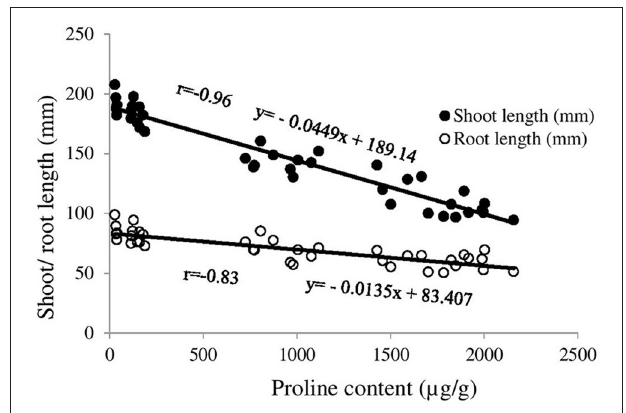
FIGURE 5 | Correlation between proline content and shoot/root length of ryegrass (post-emergent). The x-axis denotes proline content of leaf ( µ g/g) and y-axis denotes shoot and root length (mm) of ryegrass. The trend line with filled circle marker represents correlation between proline content and shoot length while trend line with non-fill circle marker represents correlation between proline content and root